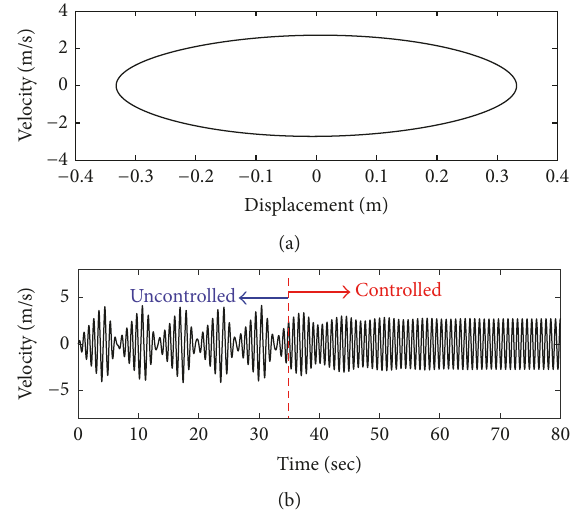
Figure 17: Transforming chaotic motion to a desired period-one orbit for 𝐺 = −0.3 and Ω = 7.964 rad/s: (a) the phase portrait for the controlled system when the state feedback control signal is introduced after 35 s and (b) the time responses of the